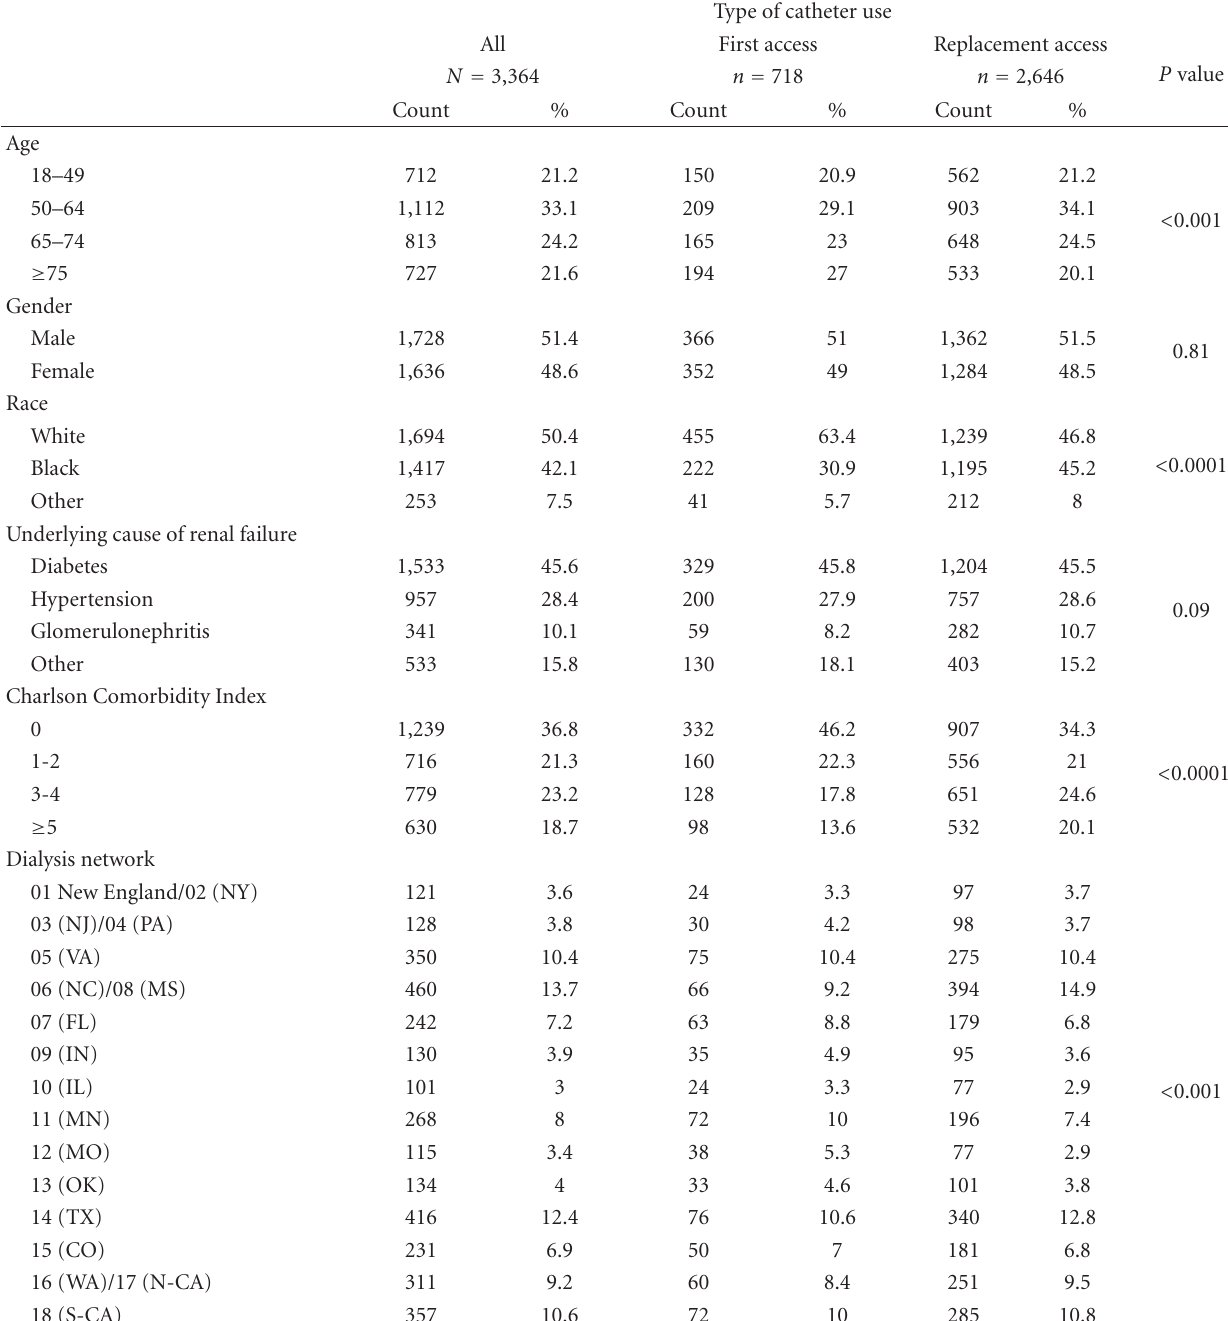
Table 1: Patient